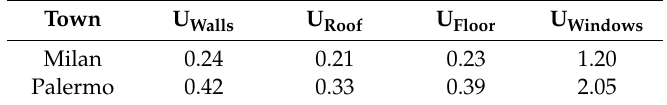
Table 3. Unitary thermal transmittance of the case study building envelope (W / m 2